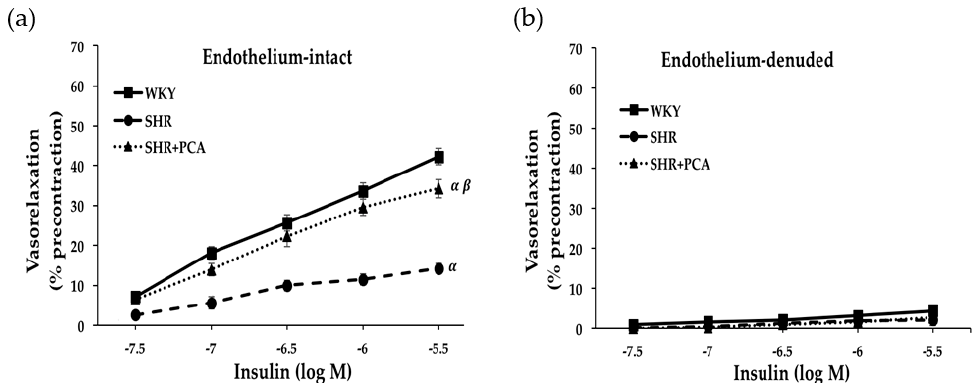
Figure 1. Insulin (3 × 10 − 8 to 3 × 10 − 6 M)-induced vasorelaxation at cumulative concentration–response curves in ( a ) endothelium-intact and ( b ) endothelium-denuded aortic rings among the WKY, SHR, and SHR+PCA groups. α , p < 0.05, significant differences from WKY; β , p < 0.05, significant differences from SHR; n = 8 in each group.